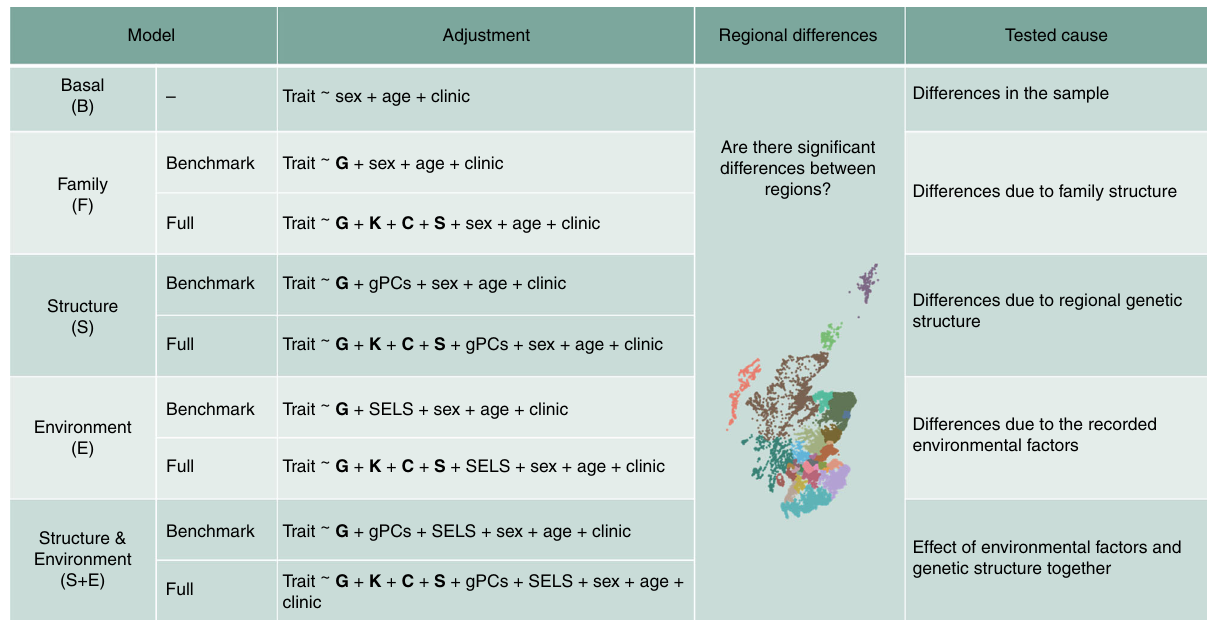
Fig. 1 Overview of the models and analyses performed. G, Genomic Relationship matrix; K, Kinship matrix; C, Couples matrix; S, Siblings matrix; gPCs, Geographic Principal Components; SELS, Socioeconomic and lifestyle